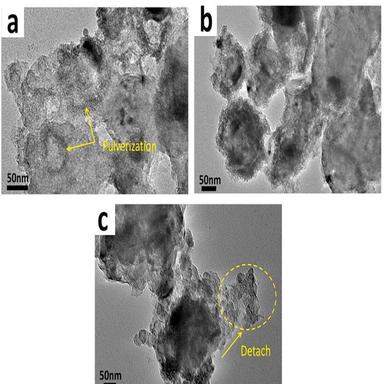
TEM images of the Fe@CoFe2O4@C electrode in the voltage windows of 0.01–3.0 V (vs. Li/Li+) at the complete lithiation (a), and delithiation state (b); in the voltage windows of 0.5–3.0 V (vs. Li/Li+) at the complete lithiation (c) after 60 cycles.